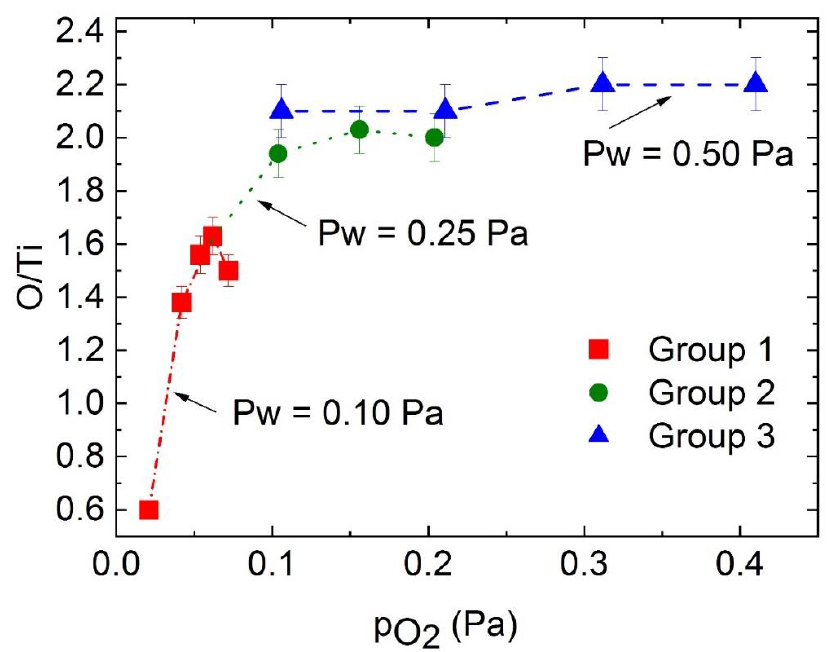
Figure 1. O/Ti ratio obtained from RBS for the different samples as a function of p O2 . The different groups are indicated by color and legend code: group 1 (square, red), group 2 (circle, green) and group 3 (triangle, blue). Samples deposited at the same P w are connected through lines, and the value of the working pressure is indicated in the graph.